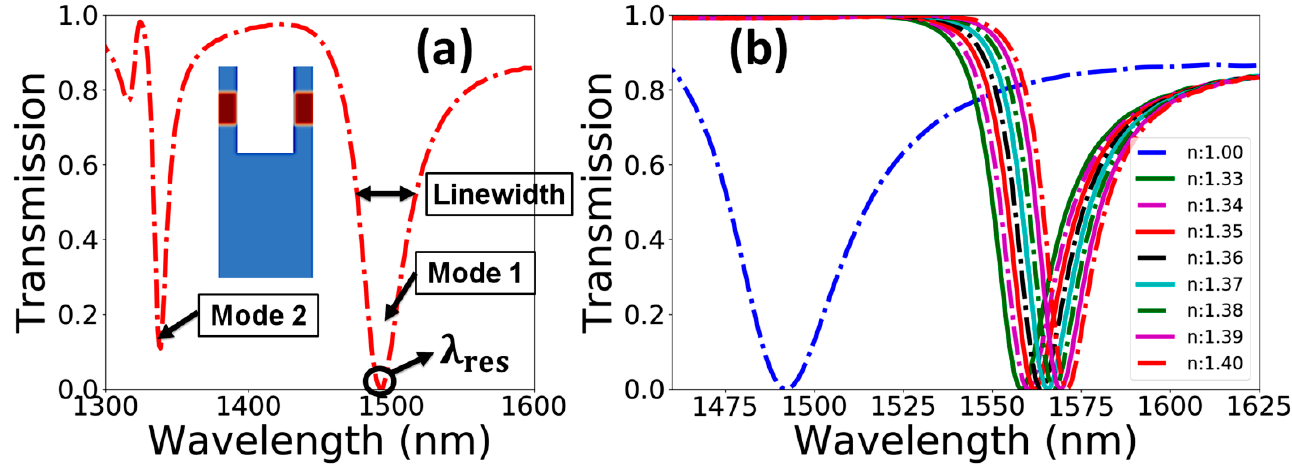
Figure 6. ( a ) Transmission and reflection spectra of the standard PhC structure with cylindrical air holes with R t / R b = 0.30/0.30 a . ( b ) Redshift in λ res as the ambient index varies from n a = 1.33 to 1.40 in a sensor device with cylinderical air holes. Dotted blue line indicating the position of resonance with air as the ambient medium.